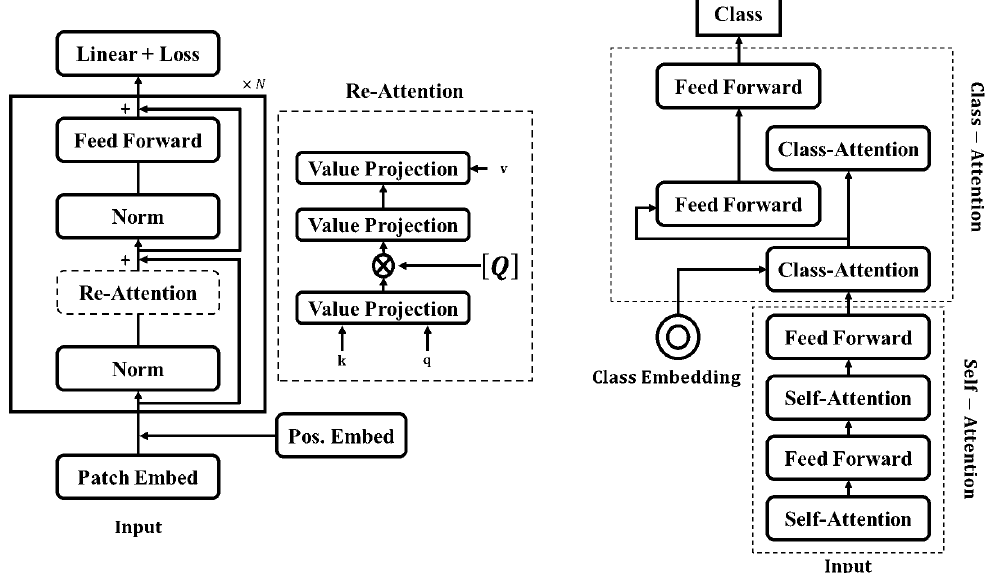
Figure 2. The transformer block in DeepViT architecture includes a re-attention module instead of a standard self-attention layer ( Left ). Class-Attention in Image Transformer architecture consists of a class embedding (CLS) and additional class-attention layers preceded by self-attention layers ( Right